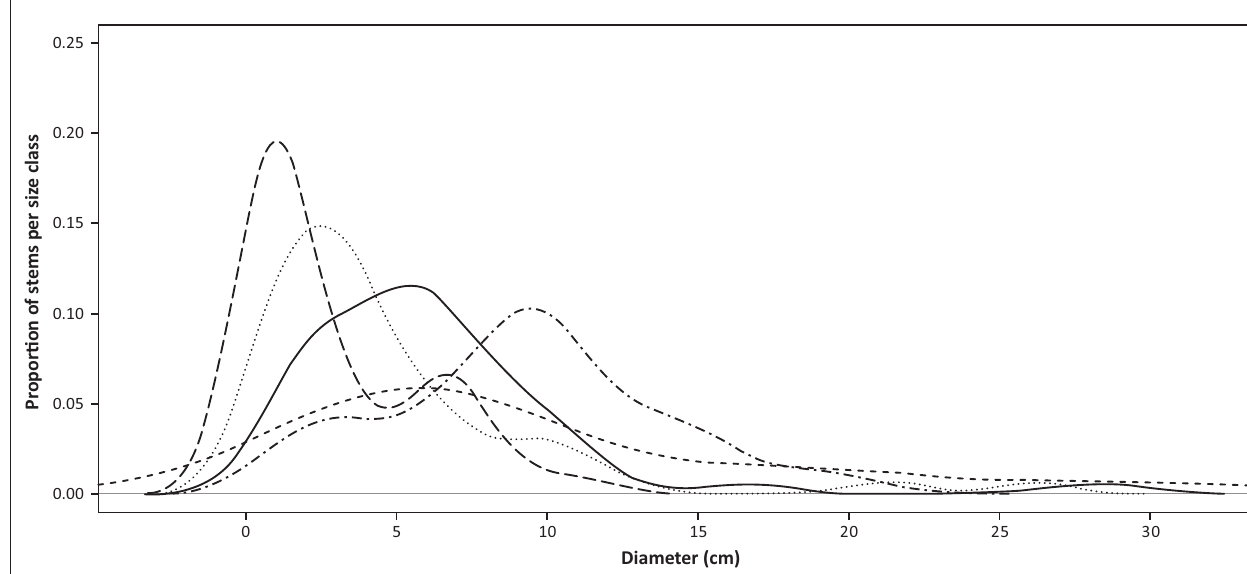
FIGURE 8 (Continues...): Density plot showing the variability in diameter size class distributions between sites: (a) Graskop sites and (b) White River sites (five sites for each location).